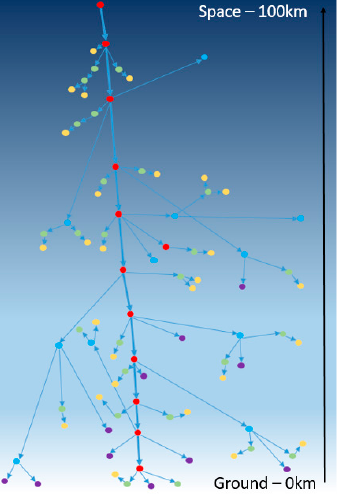
Figure 1. Schematic of the Extensive Atmospheric Shower phenomenon (proton: red, electron: green, photon: yellow, neutron: blue, muon: purple).